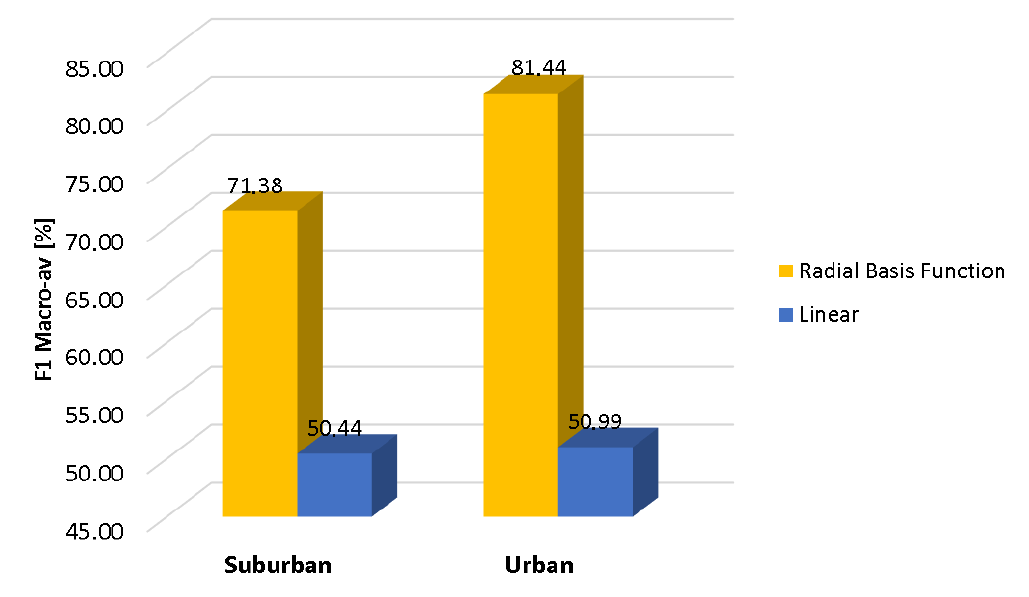
Figure A3. SVM optimization results using the real-life suburban and urban databases, respectively. A different type of kernel has been used for each experiment (see the figure legend). This result demonstrates that the addressed classification problem is clearly non-linear.